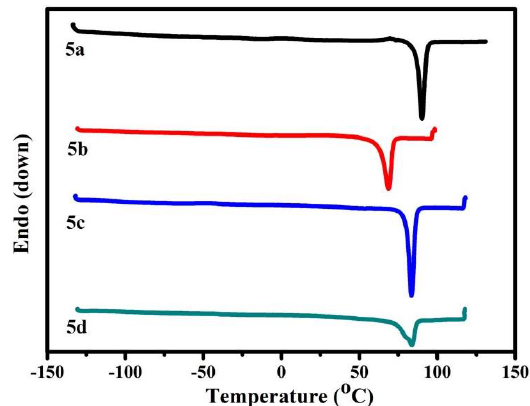
Figure 3. Differential scanning calorimetry (DSC) curves for B-L MILs obtained at a heating rate of 5 °C min − 1 . Table 3. Summary of B-L MIL melting points obtained using DSC and capillary melting point apparatus (DSC: differential scanning calorimetry, MP-S3: melting point apparatus).